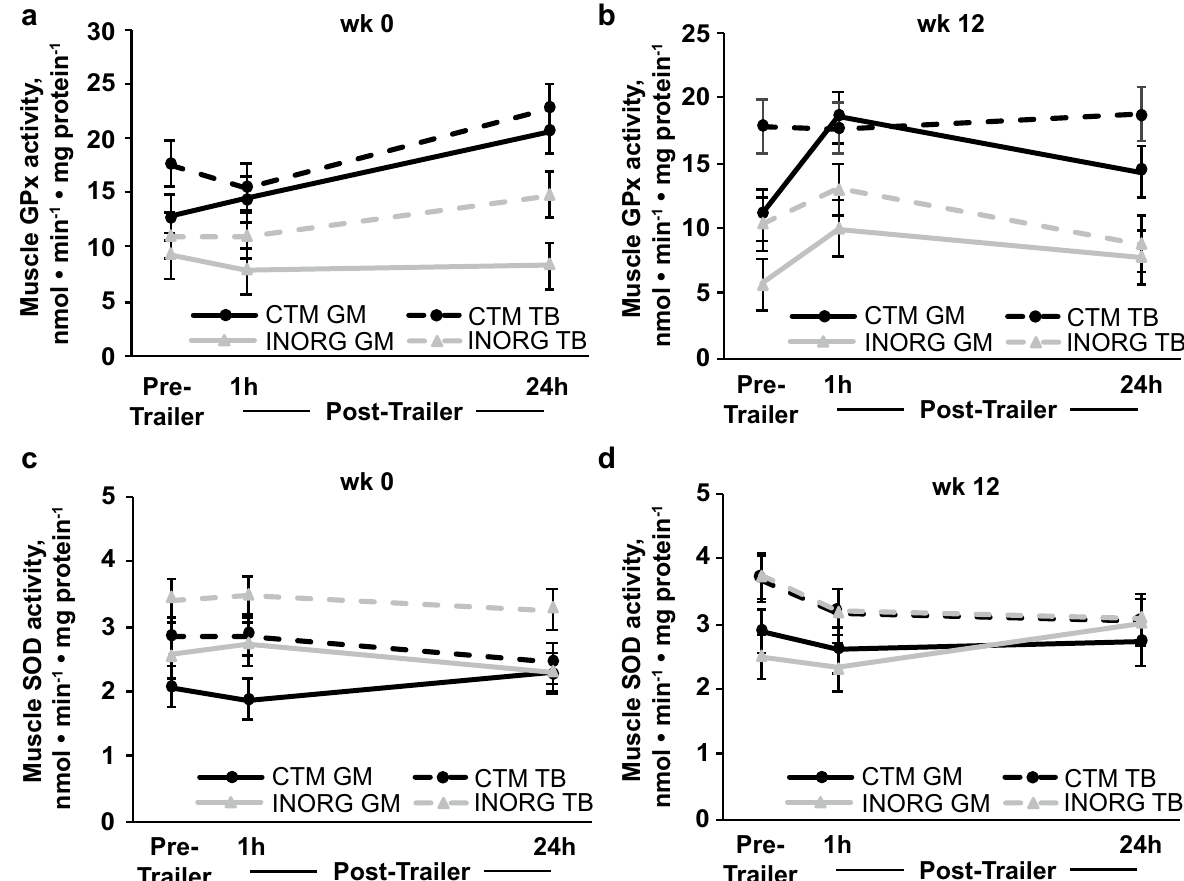
Figure 3. Gluteus medius (GM) and triceps brachii (TB) glutathione peroxidase (GPx; a , b ) and superoxide dismutase (SOD; c , d ) activites before (pre-trailer), and 1 (1 h) and 24 h (24 h) after a 1.5-h trailer stressor. Trailer stressors occurred before (week 0; a , c ) and after (week 12; b , d ) 12 weeks of submaximal exercise training in yearling horses supplemented with either complexed trace minerals (CTM; n = 8) or inorganic trace minerals (INORG; n = 8). Overall effect of diet ( P = 0.0002; P = 0.0003; P = 0.061; P = 0.941), trailering ( P = 0.055; P = 0.011; P = 0.697; P = 0.662), muscle group ( P = 0.005; P = 0.001; P < 0.0001; P = 0.011), diet × trailering ( P = 0.370; P = 0.522; P = 0.737; P = 0.777), diet × muscle group ( P = 0.307; P = 0.979; P = 0.507; P = 0.367), time × muscle group ( P = 0.941; P = 0.069; P = 0.701; P = 0.501) and diet × time × muscle group ( P = 0.533; P = 0.485; P = 0.415; P = 0.443) for panels ( a – d ),